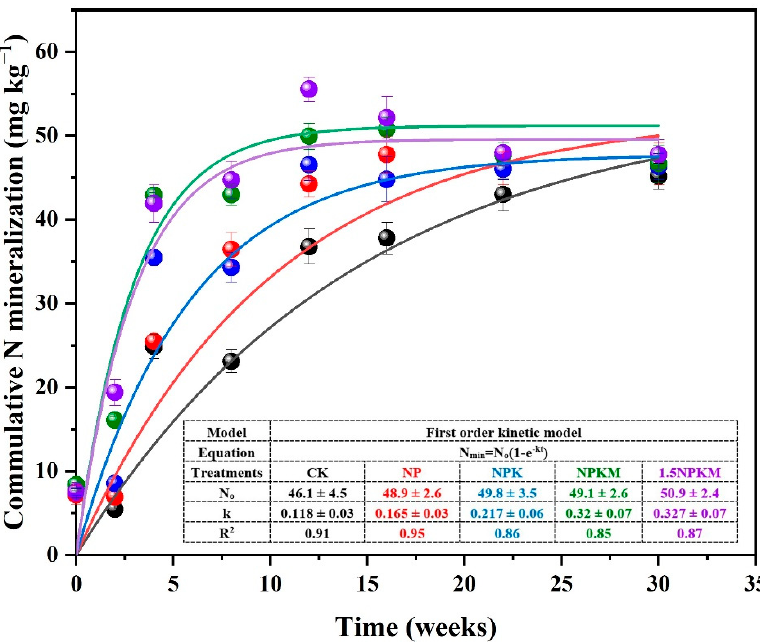
Figure 2. Cumulative mineralized N, N mineralization potential ( N 0 ), and constant rate ( k ) differences among treatments with long-term fertilization treatments in relation to time. The N 0 and k were obtained according to equation ( N min = N 0 (1 − e − kt ). CK-1.5NPKM represents the treatments from: no fertilization (CK), chemical nitrogen and phosphorus fertilizer (NP), NP with K fertilizer (NPK), NPK with manure application (NPKM), 1.5 rates of NPKM (1.5NPKM).